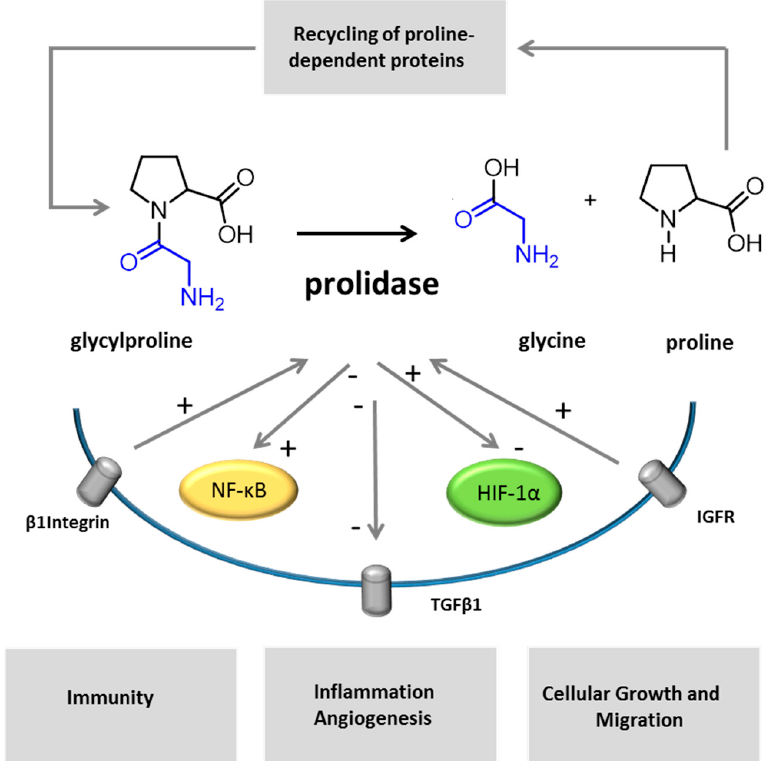
Figure 4. Different mechanisms may be involved in the pathophysiology of PD. Imidodipeptides, as glycylproline, are split out by prolidase. In the representation of the enzymatic reaction, glycine is colored in blue, proline in black. Prolidase activity participates to the recycling of imidopeptide-containing proteins. As reported by previous studies, other cellular factors and receptors are dependent on, or are regulated by, prolidase activity or expression (IGFR, HIF-1 α , TGF β 1 and NK- κ B). Insulin growth factor and β 1 integrin receptor signaling upregulate prolidase activity [2,95–97]. Inhibitors of prolidase activity induce a decrease of TGF β 1 and its receptor [100] and upregulates NF- κ B expression [2]. HIF-1 α expression was shown to be prolidase-dependent [2,105].